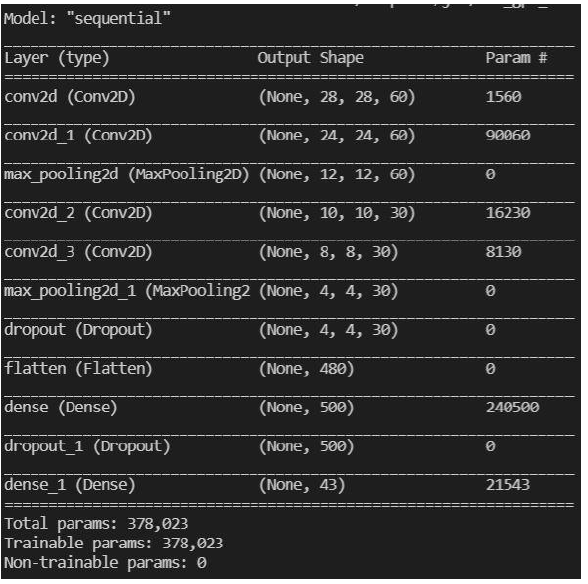
Fig. 12. Each Iteration Details Fig.12 Represents the Accuracy and loss of the model at each Iteration. It can be seen that accuracy is increasing with each epoch.